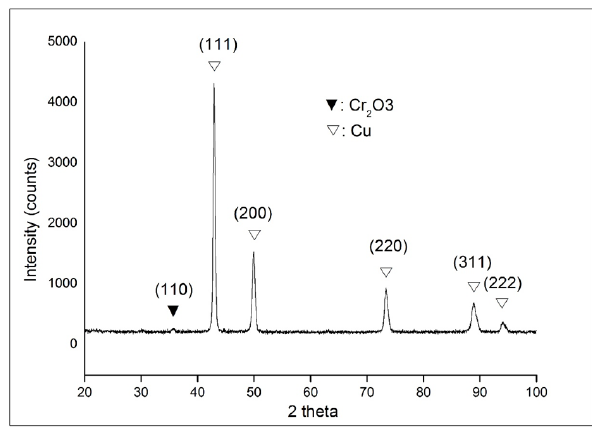
Figure 2: XRD pattern of the HPed Cu with Cr 2 O 3 dispersoids (the peaks of Cu and Cr2O3 are clearly identified).